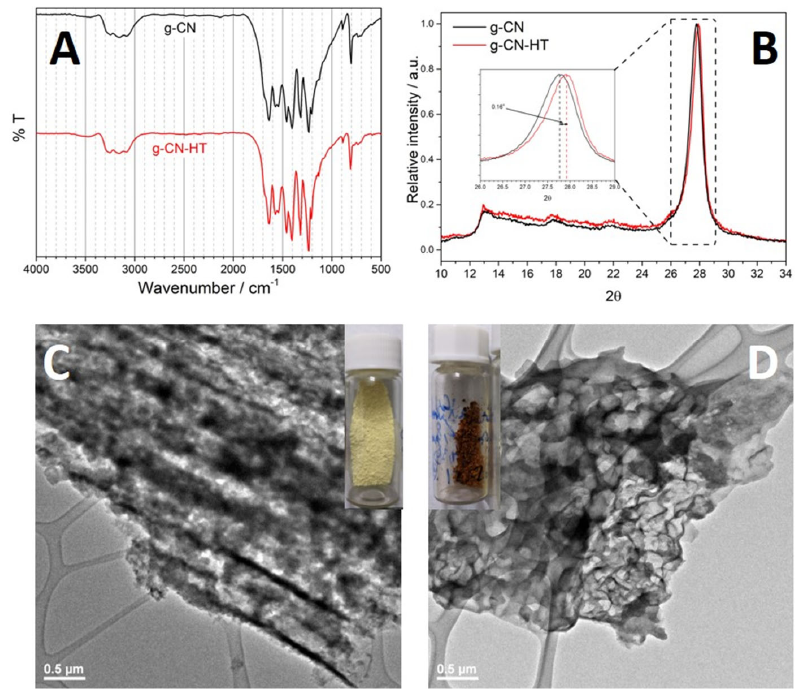
Figure 1. Structure and morphology of g-CN and g-CN-HT. Fourier-transform infrared spectroscopy of g-CN, black line, and g-CN-HT, red line ( A ); X-ray diffractograms of g-CN, black line, and g-CN-HT, red line ( B ); transmission electron microscopy of g-CN ( C ) and g-CN-HT ( D ).